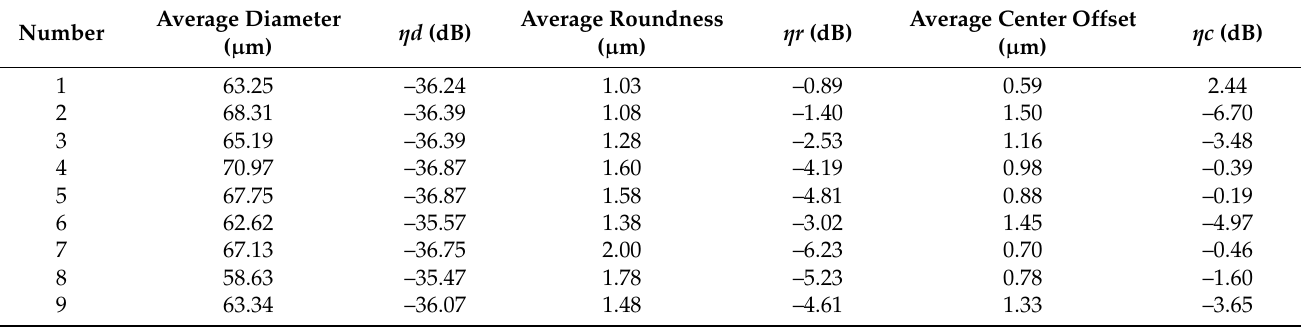
Table 4. Experimental results and S/N ratios for diameter, roundness, and center